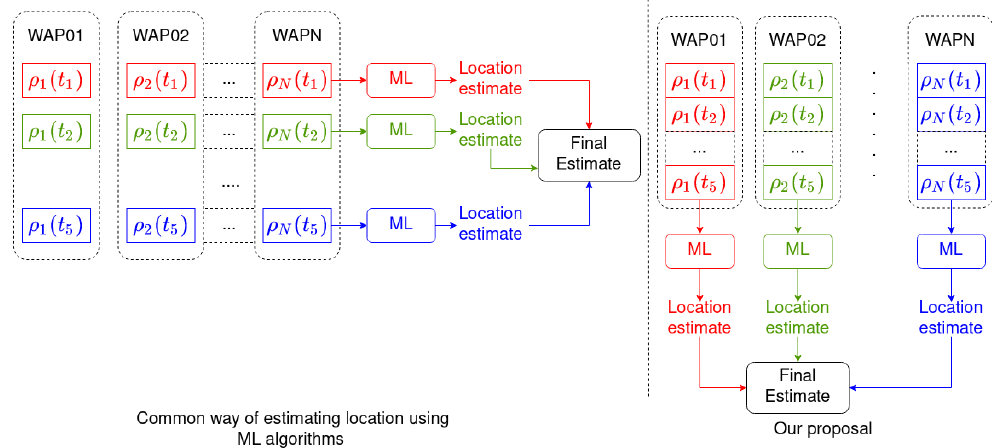
Figure 3. On the left, how most indoor localization methods perform location estimation: a single vector of RSSI samples received from different WAPs is used to estimate the location (horizontal grouping); then several estimations are combined to generate the final estimation. In the method presented in this paper ( right ), a vector of RSSI samples received from the same WAP is used to estimate the location (vertical grouping); then several estimations are combined to generate the final estimation. A sample size of 5 is given as an example. Colors have been used to show the different paths through which the data are processed in both